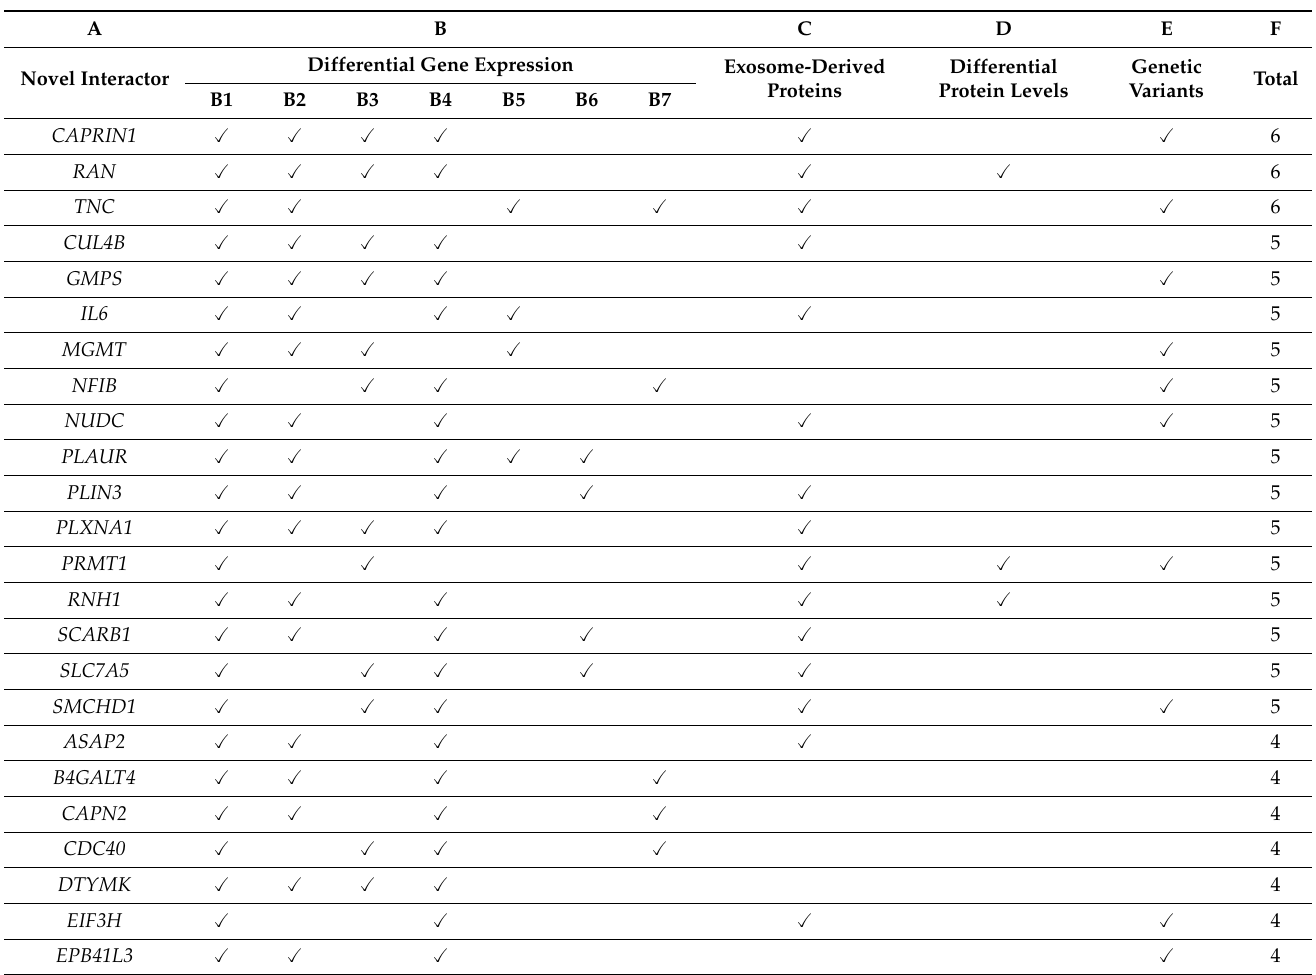
Table 4. Novel interactors in the malignant pleural mesothelioma (MPM) interactome with biological evidences related to MPM. The table shows the following data in columns labeled A to F. (A) 48 novel interactors of MPM associated genes that have been linked to four or more biological evidences related to MPM, namely, B1 : high or medium gene expression in lungs, B2 : differential gene expression in MPM tumor versus other thoracic tumors, B3 : differential gene expression in MPM tumor versus normal adjacent pleural tissue, B4 : differential gene expression in MPM tumors of epithelioid, biphasic and sarcomatoid types, B5 : differential gene methylation in MPM, B6: gene expression correlated with unfavorable lung cancer prognosis, B7 : differential gene expression on exposure to asbestos or asbestos-like particles, C : isolation as exosome-derived proteins from malignant mesothelioma cell lines, D : differential protein abundance levels in epithelioid and sarcomatoid types of malignant mesothelioma, and E : genetic variants in MPM. Last column, F , gives the total number of sources of evidences for each gene. The complete list of biological evidence for all the genes in the interactome can be found in Data File S5.